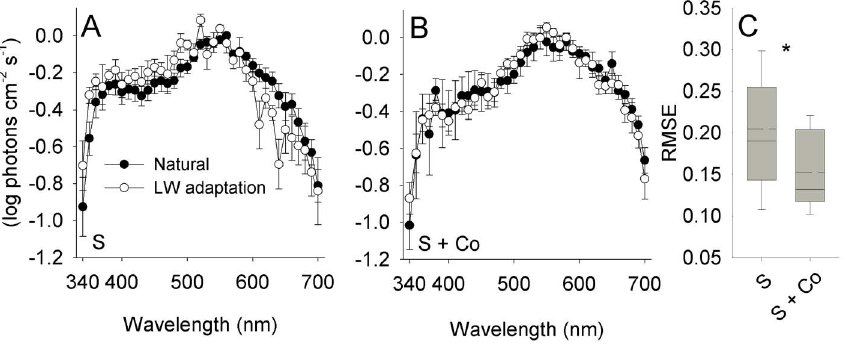
Figure 4. HC-cone feedback increases the efficiency of color induction in the output of cones. (A,B) Spectral sensitivity of the output of cones measured from saline-treated retina (S) and retina treated with saline and cobalt (S + Co). Error bars, 6 1 SEM. Sample size: S: Natural=5, LW adaptation=5; S + Co: Natural=4, LW adaptation=5. (C) The efficiency of color induction, as indicated by the RMSE between the spectral sensitivity under the two backgrounds, decreased significantly with the application of cobalt (marked with an asterisk; see text for statistics). Box specifications as in Figure 3.